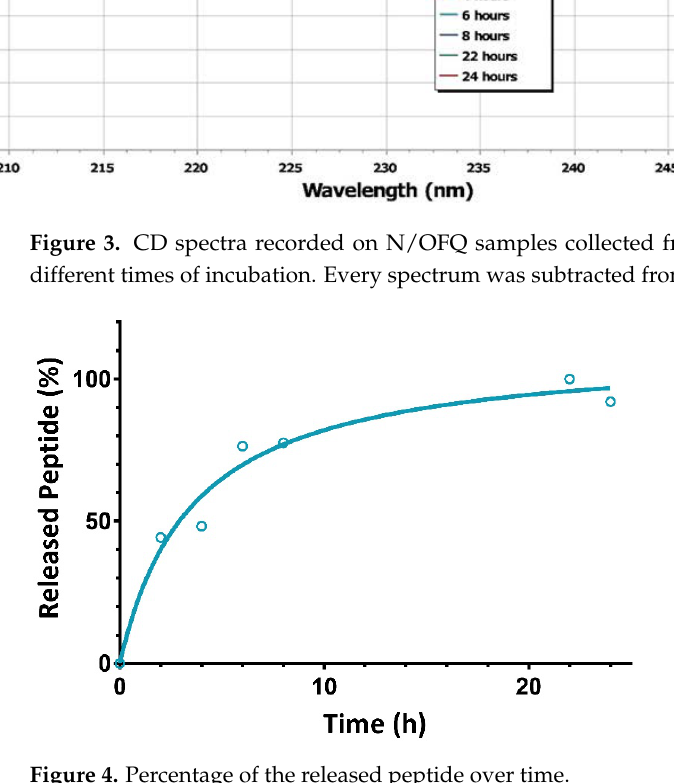
Figure 4. Percentage of the released peptide over time. Moreover, OVA sensitization induced a significant increase in total inflammatory cell numbers ( p < 0.01) that was significantly reduced by essential thrombocythaemia (e.t.) treatment with N/OFQ-SLNs ( p < 0.01), returning the total cell count to